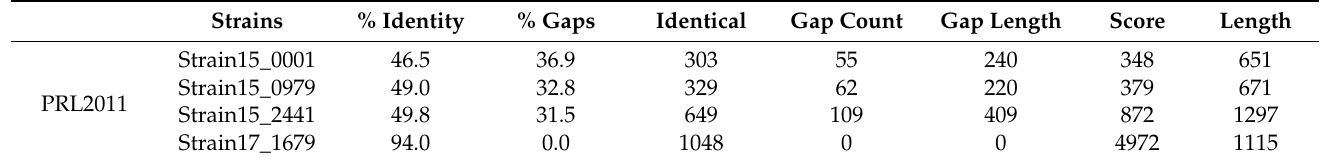
Table 6. Results of single alignment (Pairwise) between nucleotides of the vanZ gene from ref-